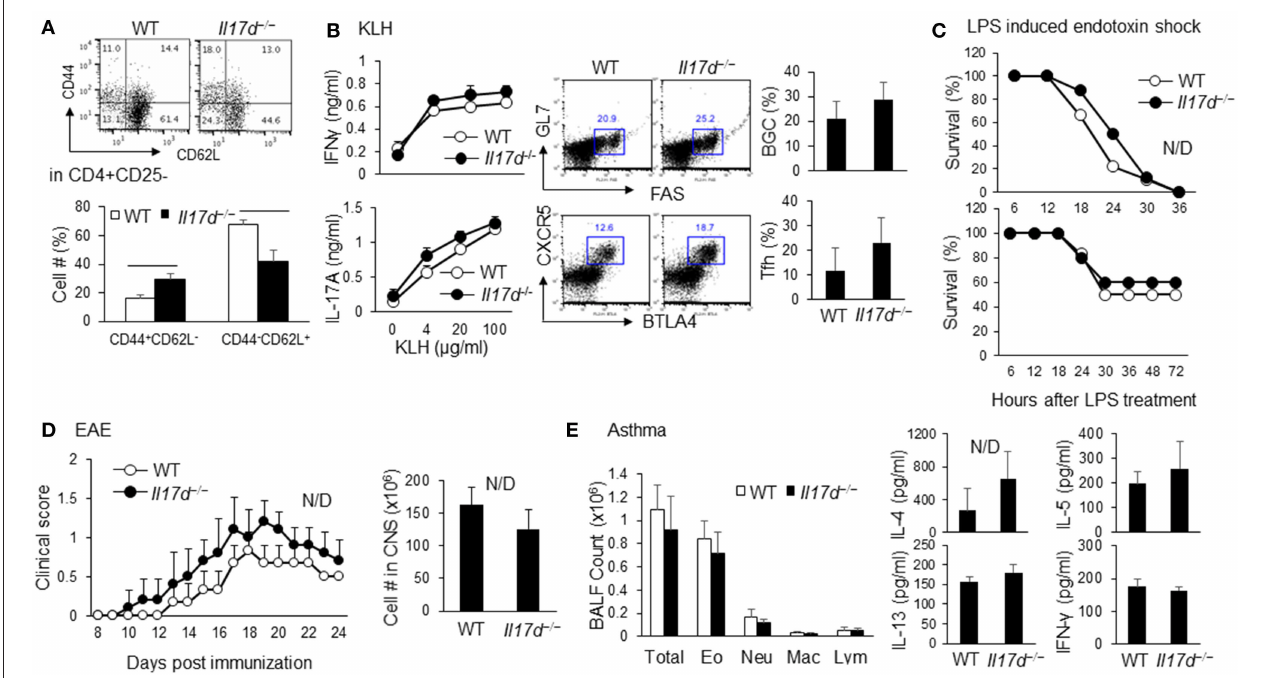
FIGURE 1 | Characterization of Il17d − / − mice in steady state and acute and chronic inflammation. (A) WT ( n = 3) or Il17d − / − ( n = 4) were analyzed at 14–16 weeks old. Effector/memory T cells (CD44 hi CD62 lo ) and naïve T cells (CD44 lo CD62L hi ) in CD4 + CD25– T cells were analyzed by FACS. (B) Spleens were re-stimulated with KLH for 3 days and subjected to IFN γ and IL-17 ELISA. Follicular helper T cells (CXCR5 + BTLA + in CD4 + T cells) and Germinal center B cells (GL7 + FAS + on B cells) were analyzed in splenocytes from WT ( n = 5) or Il17d − / − mice ( n = 4) 7 days after KLH/CFA immunization. (C) WT and Il17d − / − mice were injected intraperitoneal with 12 mg/kg LPS (Top, WT n = 9; Il17d − / − n = 8) and 5 mg/kg LPS (Bottom, WT n = 6; Il17d − / − n = 5). Survival was monitored up to 72h. (D) Clinical scores of WT ( n = 5) or Il17d − / − mice ( n = 3) after EAE induction. Mice were immunized with MOG/CFA and injected with pertussis toxin; disease progression was monitored daily. Numbers of infiltrated cells in the CNS of WT or Il17d − / − mice on day 24. (E) Total cell counts and the presence of Th2 cytokines (IL-4, IL-5, and IL-13) in the BAL fluid of WT or Il17d − / − mice immunized with OVA in alum on days 0 and 14, followed by intranasal challenge with OVA on days 14, 25, and 26. Data are from two to three